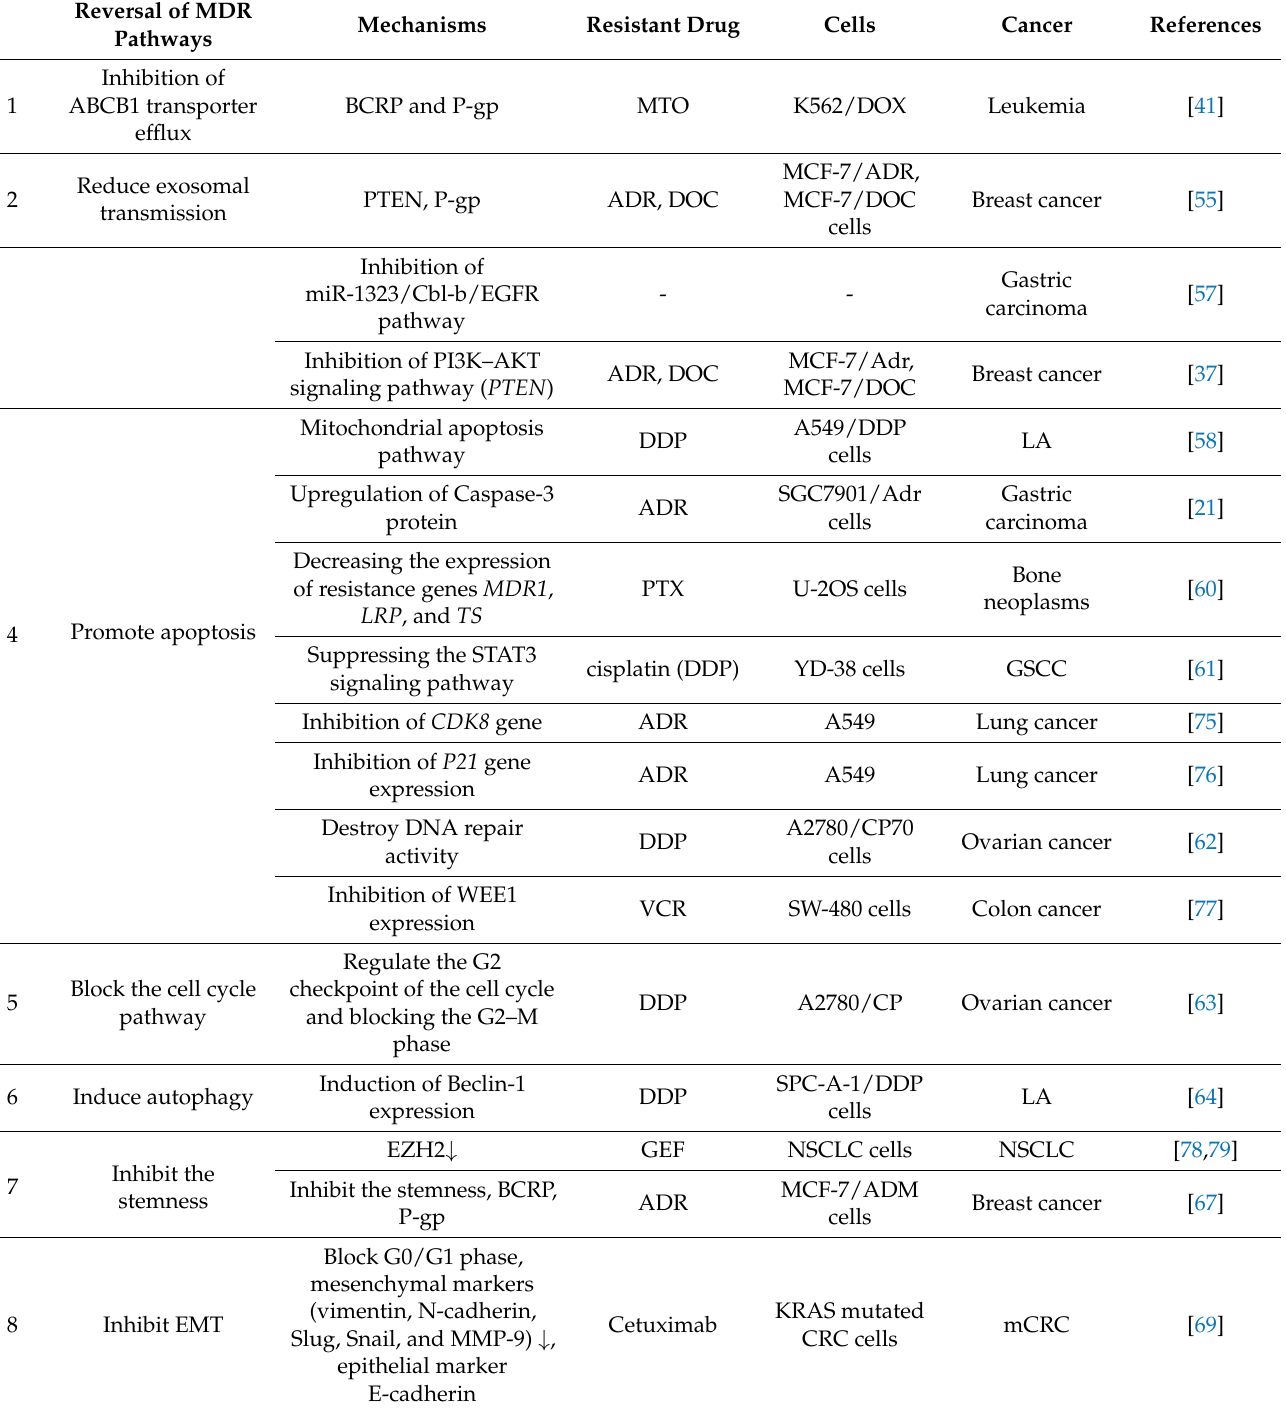
Table 1. Mechanisms of elemene reversing multidrug resistance in